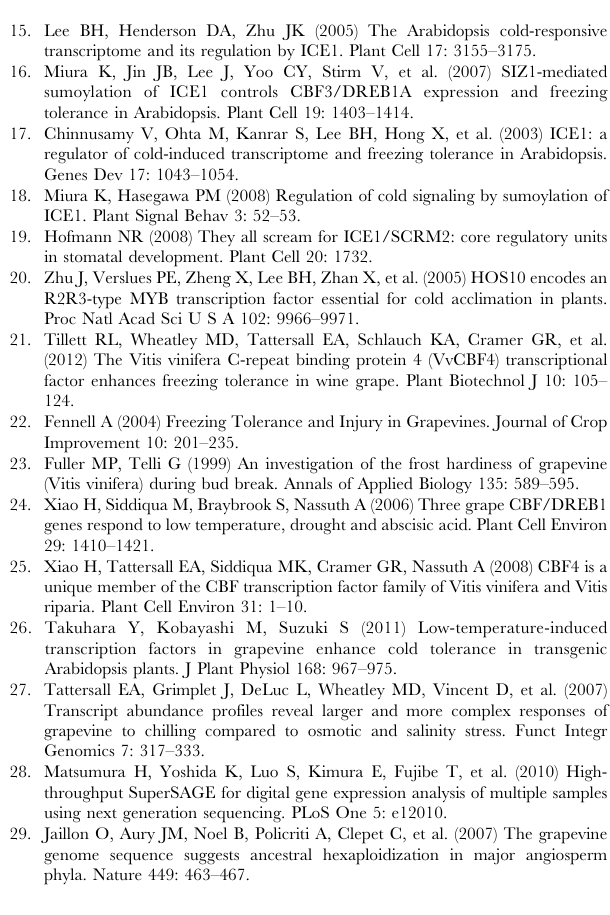
Table S1 Detail information of DEGs in V. amurensis and V. vinifera cv. Muscat of Hamburg. Table S2 List of primers used for the Real-time RT-